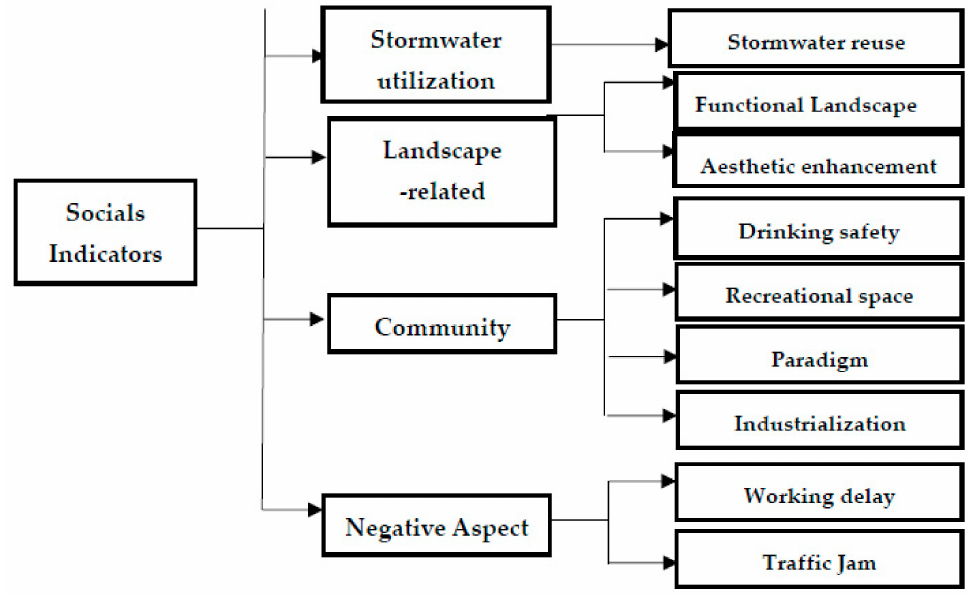
Figure 4. Social